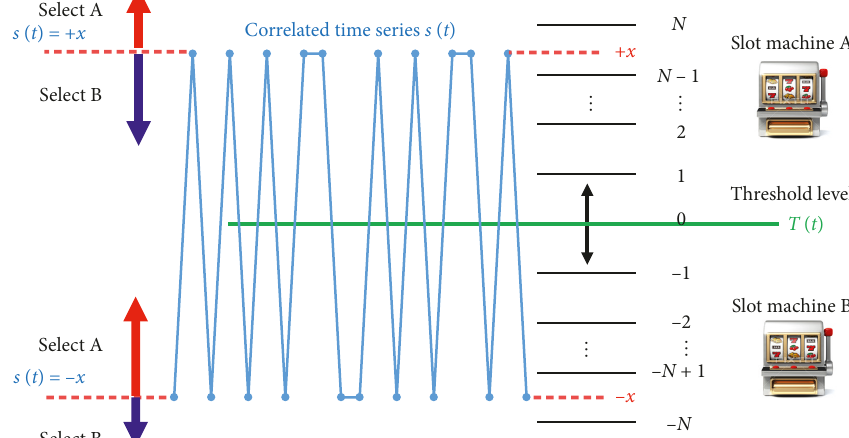
Figure 3: The theoretical model of the decision-making based on correlated time series and reconfiguration of the